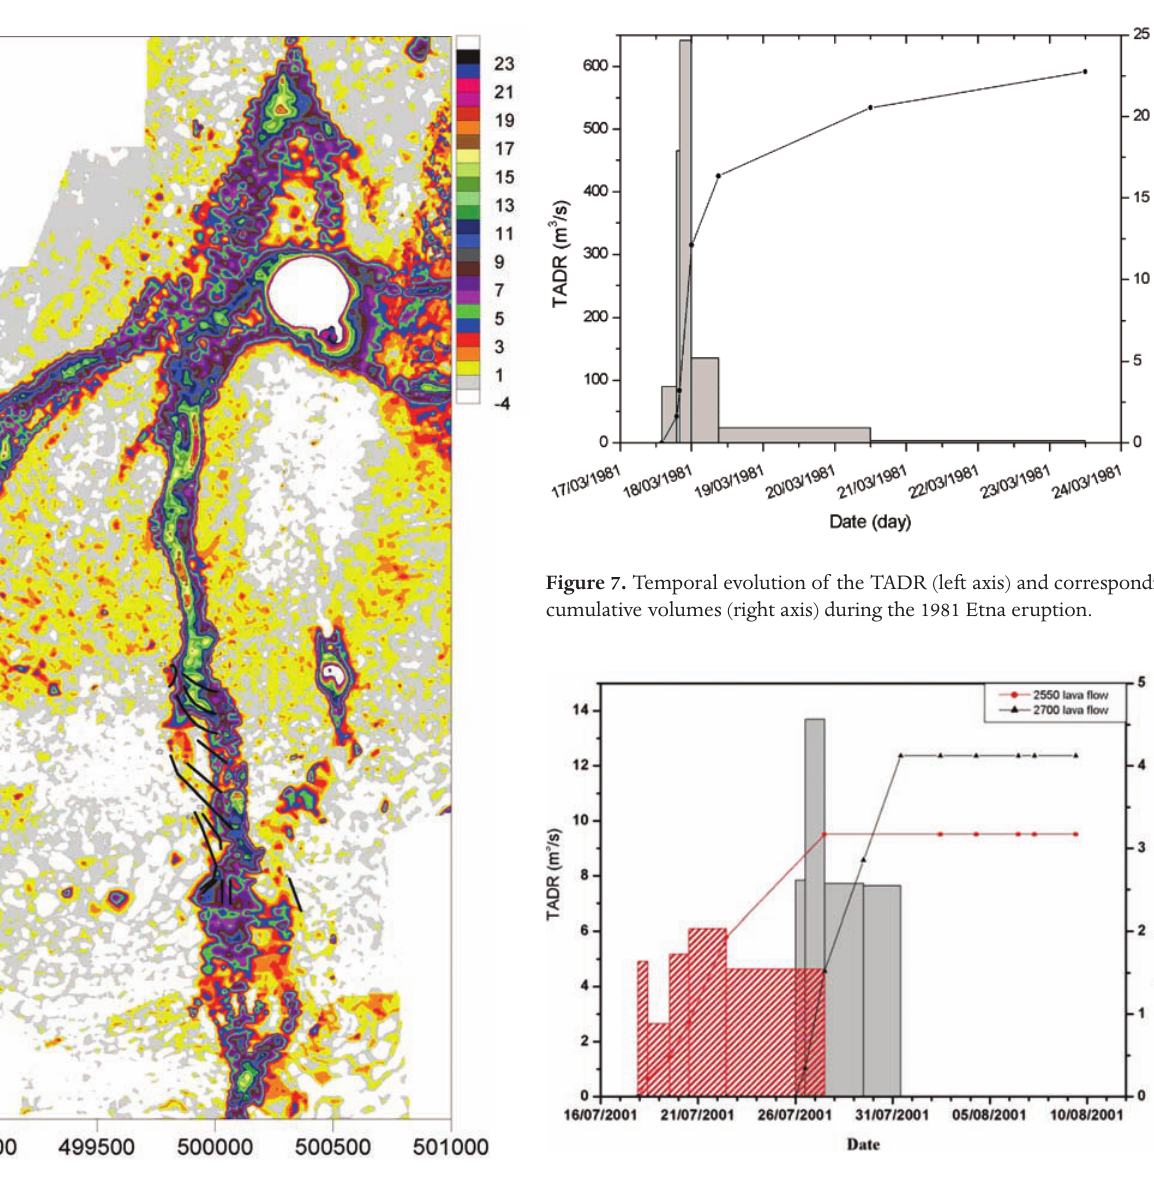
Figure 8. Temporal evolution of the TADR (left axis) and the corresponding cumulative volumes (right axis) during the 2001 Etna eruption. Gray bars and black triangles, lava flow from the 2,550 m a.s.l. vent. Red bars and red circles, lava flow from the 2,700 m a.s.l. vent. (from Scifoni et al.